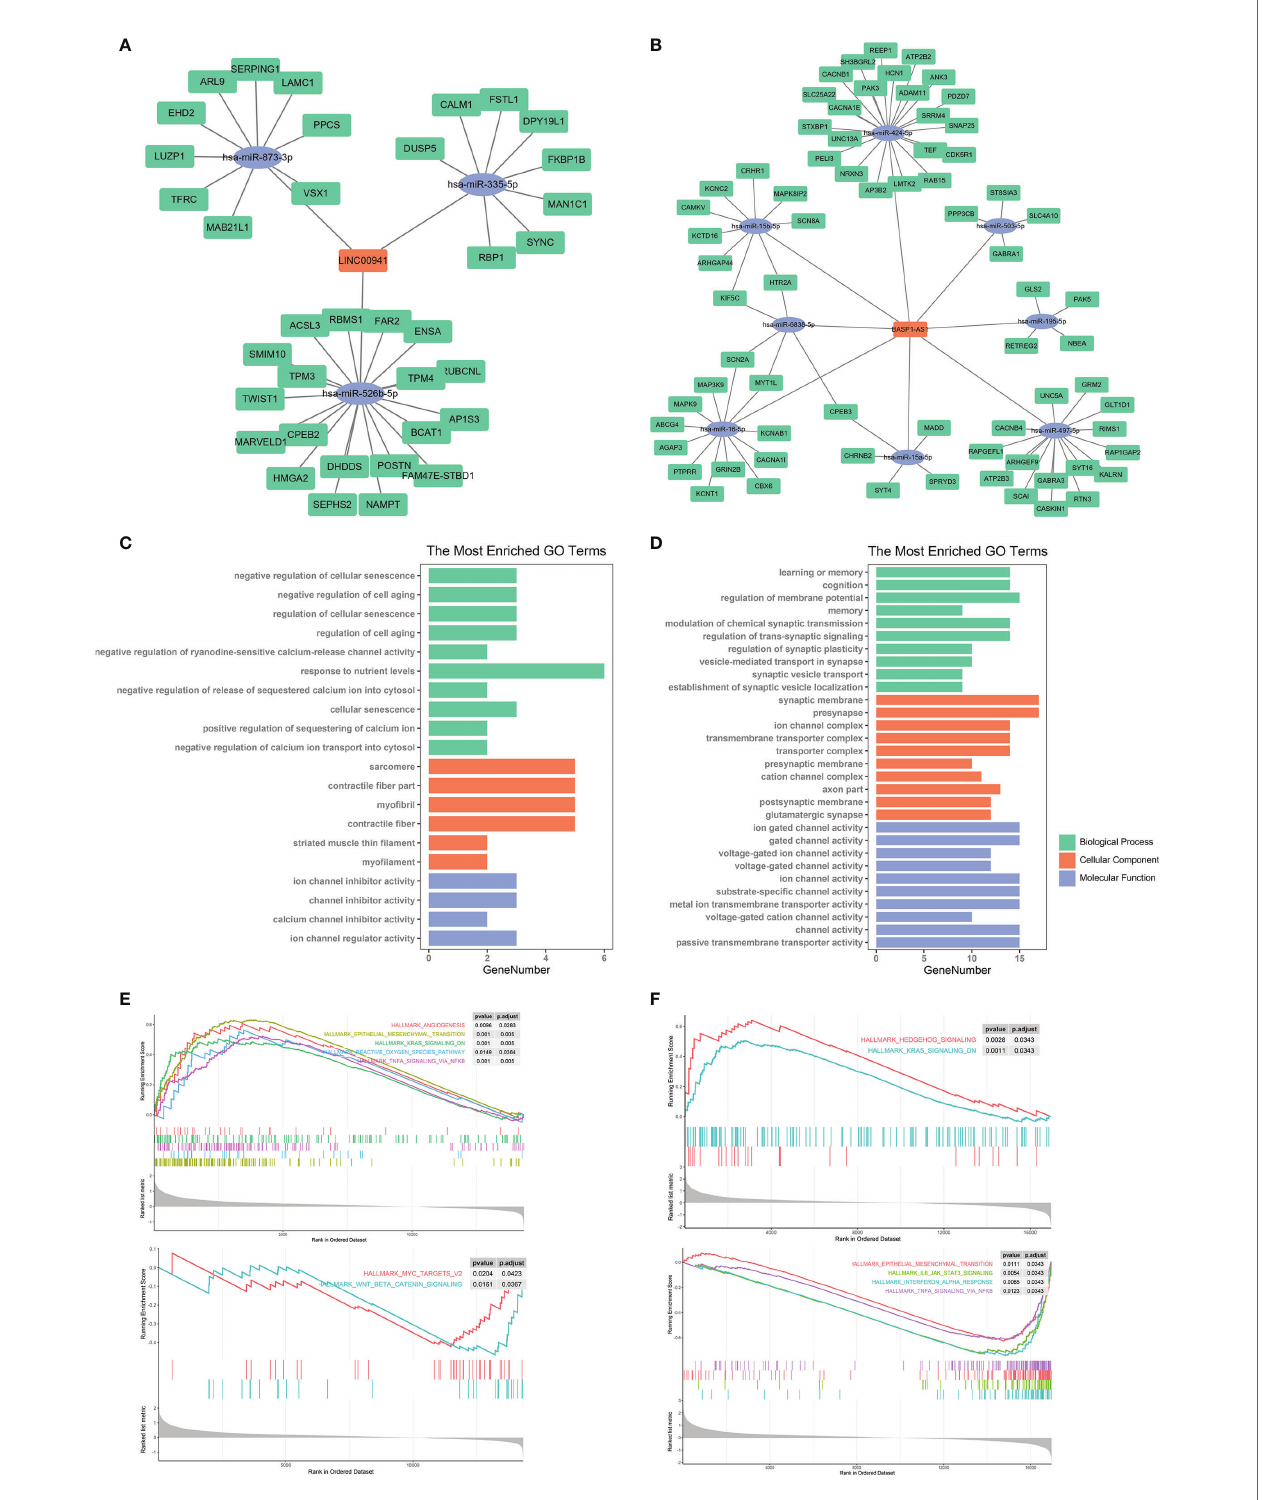
FIGURE 9 | Bioinformatic analysis of molecular mechanisms underlying LINC00941 and BASP1-AS1. (A, B) Competing endogenous RNA network of LINC00941 (A) and BASP1-AS1 (B) . (C, D) Enrichment analysis of targeting mRNAs of LINC00941 (C) and BASP1-AS1 (D) . (E, F) Gene set enrichment analysis of differentially expressed genes between high- and low-expression of LINC00941 (E) and BASP1-AS1 (F)